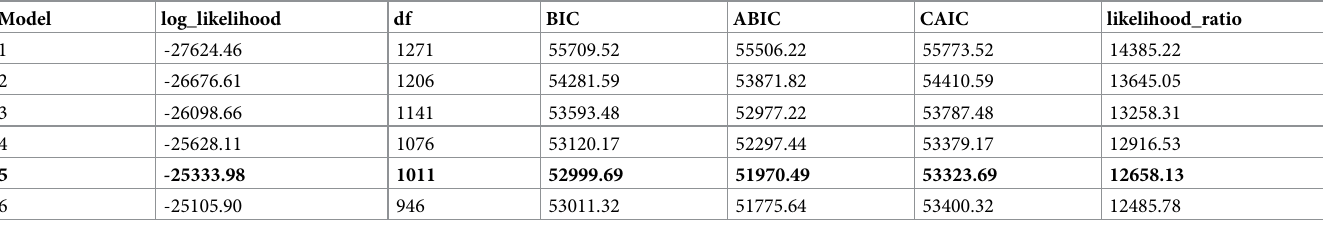
Table 4. Goodness of fit for latent classes corresponding to groups with different